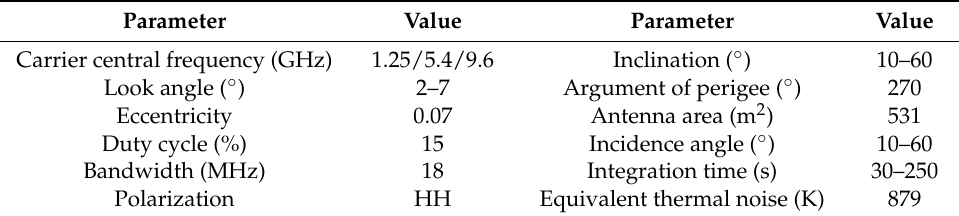
Table 2. Classical parameters of the inclined orbit GEO SAR system.